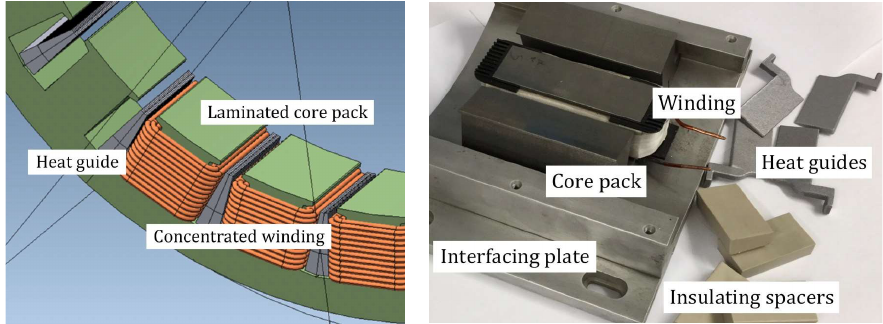
Figure 5. A concentrated winding electrical machine with heat guide